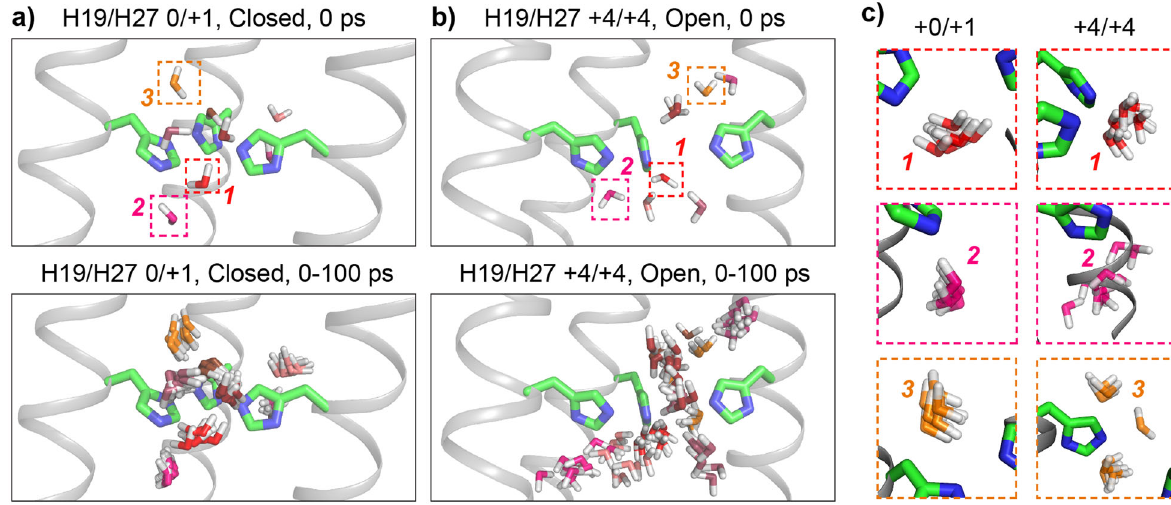
Fig. 4 Representative snapshots of rotational and translational diffusion of water molecules within 3Å of H19. a Water molecules near H19 in the closed 0/ + 1 channel. b Water molecules near H19 in the open + 4/ + 4 channel. The composite views at the bottom are taken in 10 ps steps over a 100-ps interval. For clarity, the oxygens of individual water molecules are colored differently. c Zoomed-in views of the trajectories of individual water molecules highlighted in a and b